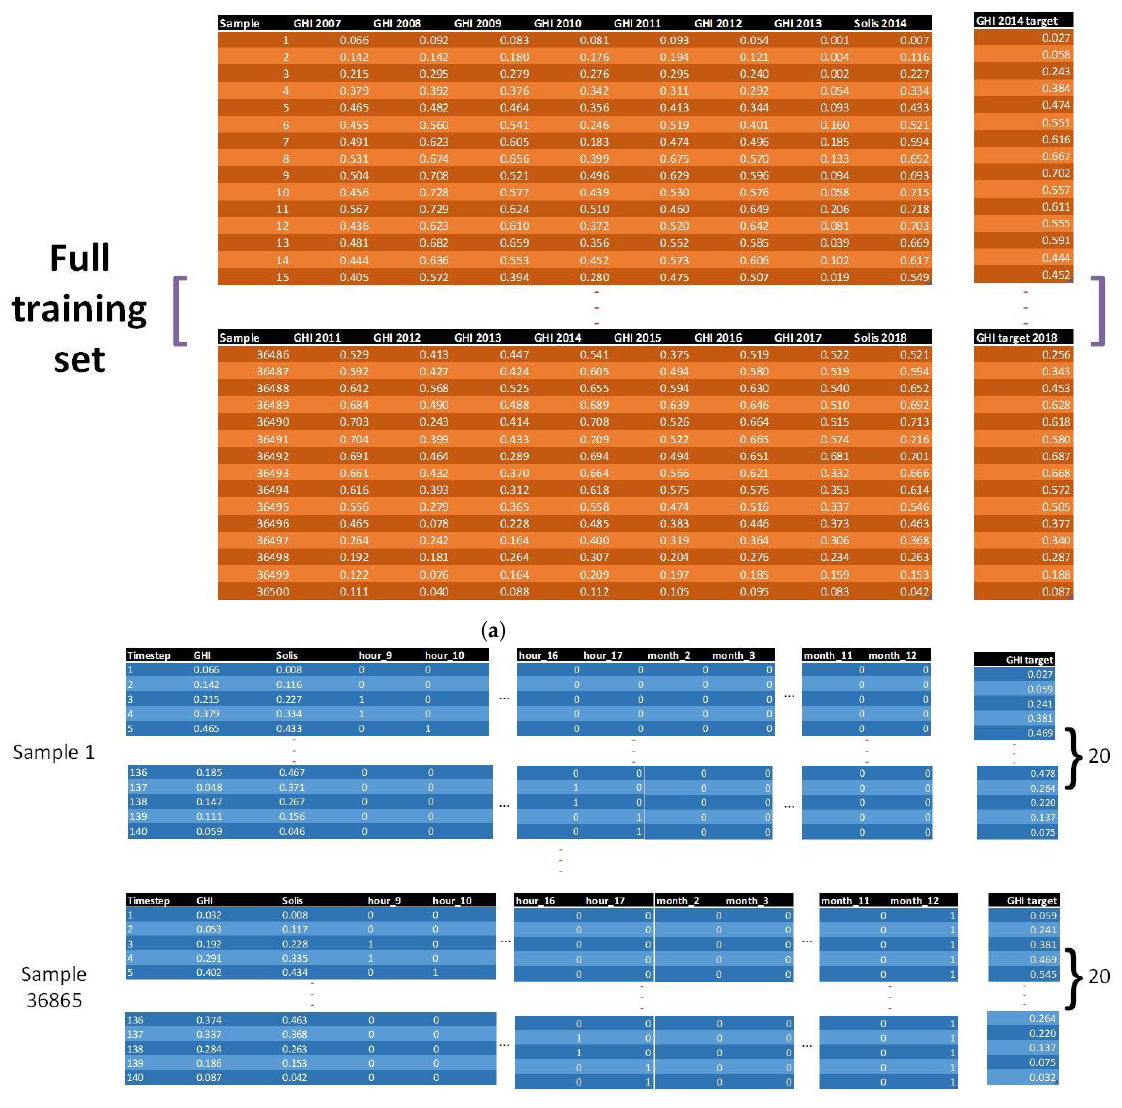
Figure 12. Different schemes to feed the data. ( a ) A scheme of training set for FFNN model. ( b ) A scheme of training set for RNN